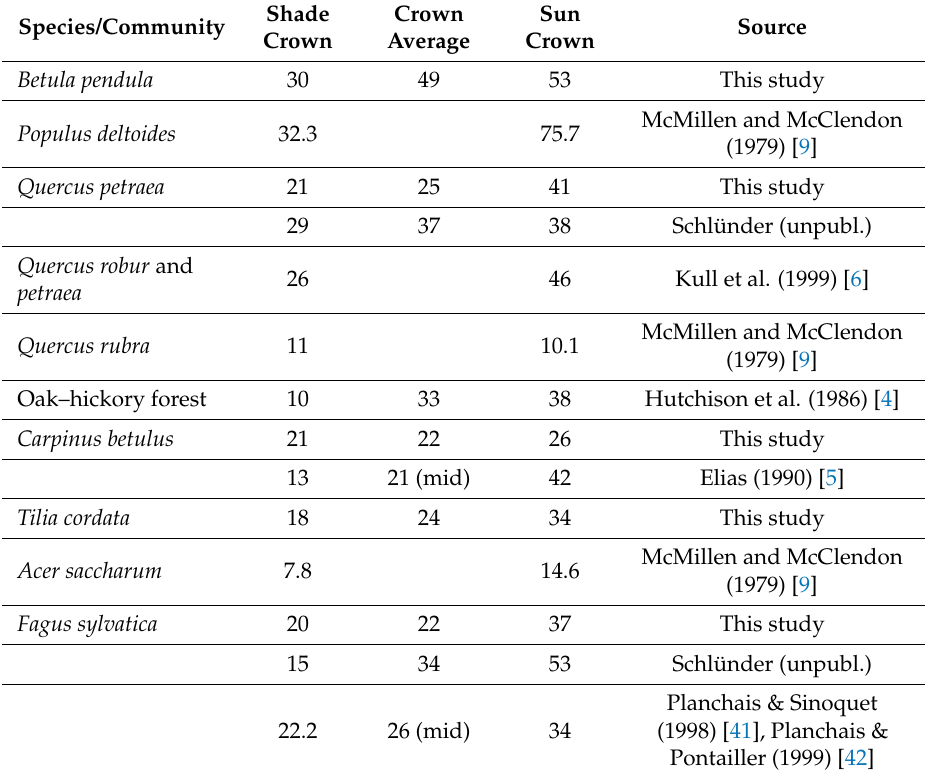
Table 6. Leaf angles (inclination in degrees relative to the horizontal) in the shade and sun crown of various temperate broadleaf trees according to literature sources. Mid = crown at mid height. Values were partly read from plotted data or calculated from ellipsoidal functions describing leaf angle distribution. Crown average stands for weighted means of the crown (if not indicated